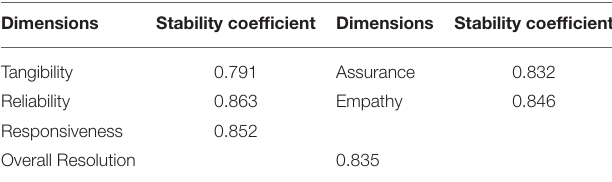
TABLE 3 | Values of stability coefficients for each of the measure